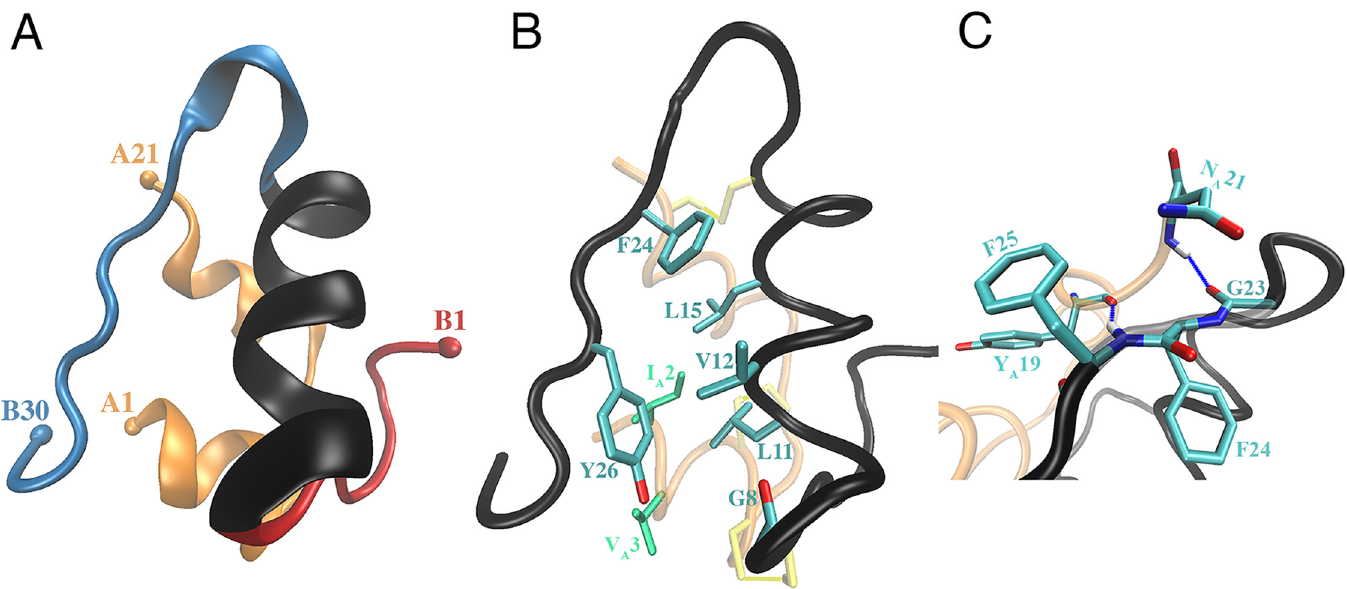
Fig 1. Structural details of the insulin molecule. (A) The structure of the insulin (PDB ID: 2G4M). A-Chain (orange); B-chain N-terminal (residues F1 – G8) (red), B-chain α -helix (residues S9 – C19) (black), B-chain C-terminal (residues G20 – T30) (blue). The colored spheres represent the C α atoms of the first and last residues of the A and B-chains. (B) The new ribbon representation shows the hydrophobic core of insulin, comprising the residues F24, L15, Y26, L11, V12, G8 (side chains shown in cyan), I2 A and V3 A (side chains shown in green). The hydroxyl group of Y26 and the oxygen atom of G8 are shown in red, and the disulfide bridges in yellow. (C) The hydrogen bonds between the residues neighboring Y24 and the A chain residues, G23(O) – N2 A (N) and F25(N) – Y19 A (O), are illustrated in blue dashed lines. Oxygen and nitrogen atoms are represented in red and blue, respectively.